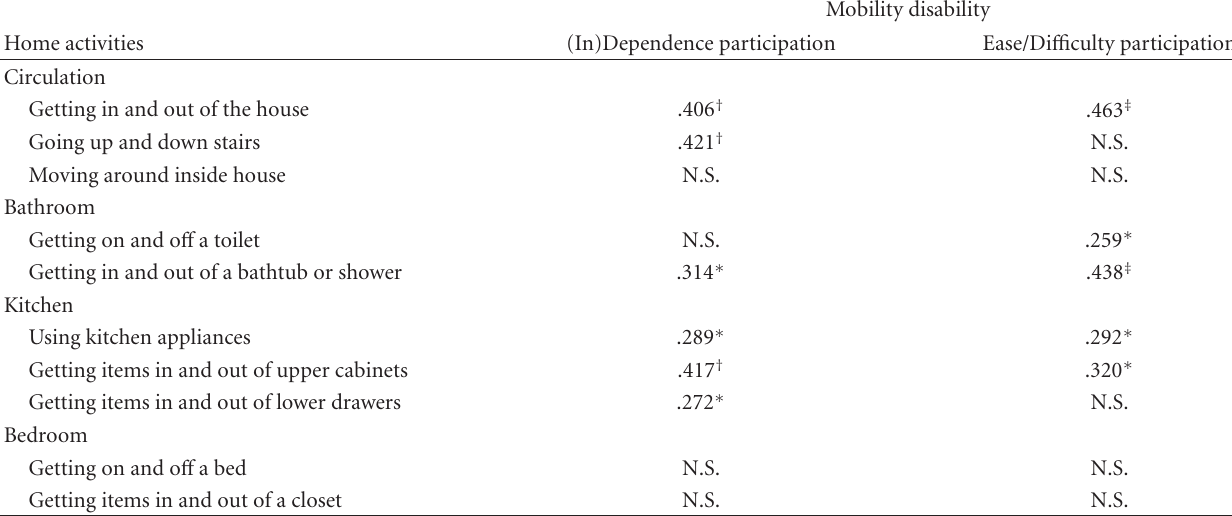
Table 7: Correlations between activity performance at home and community